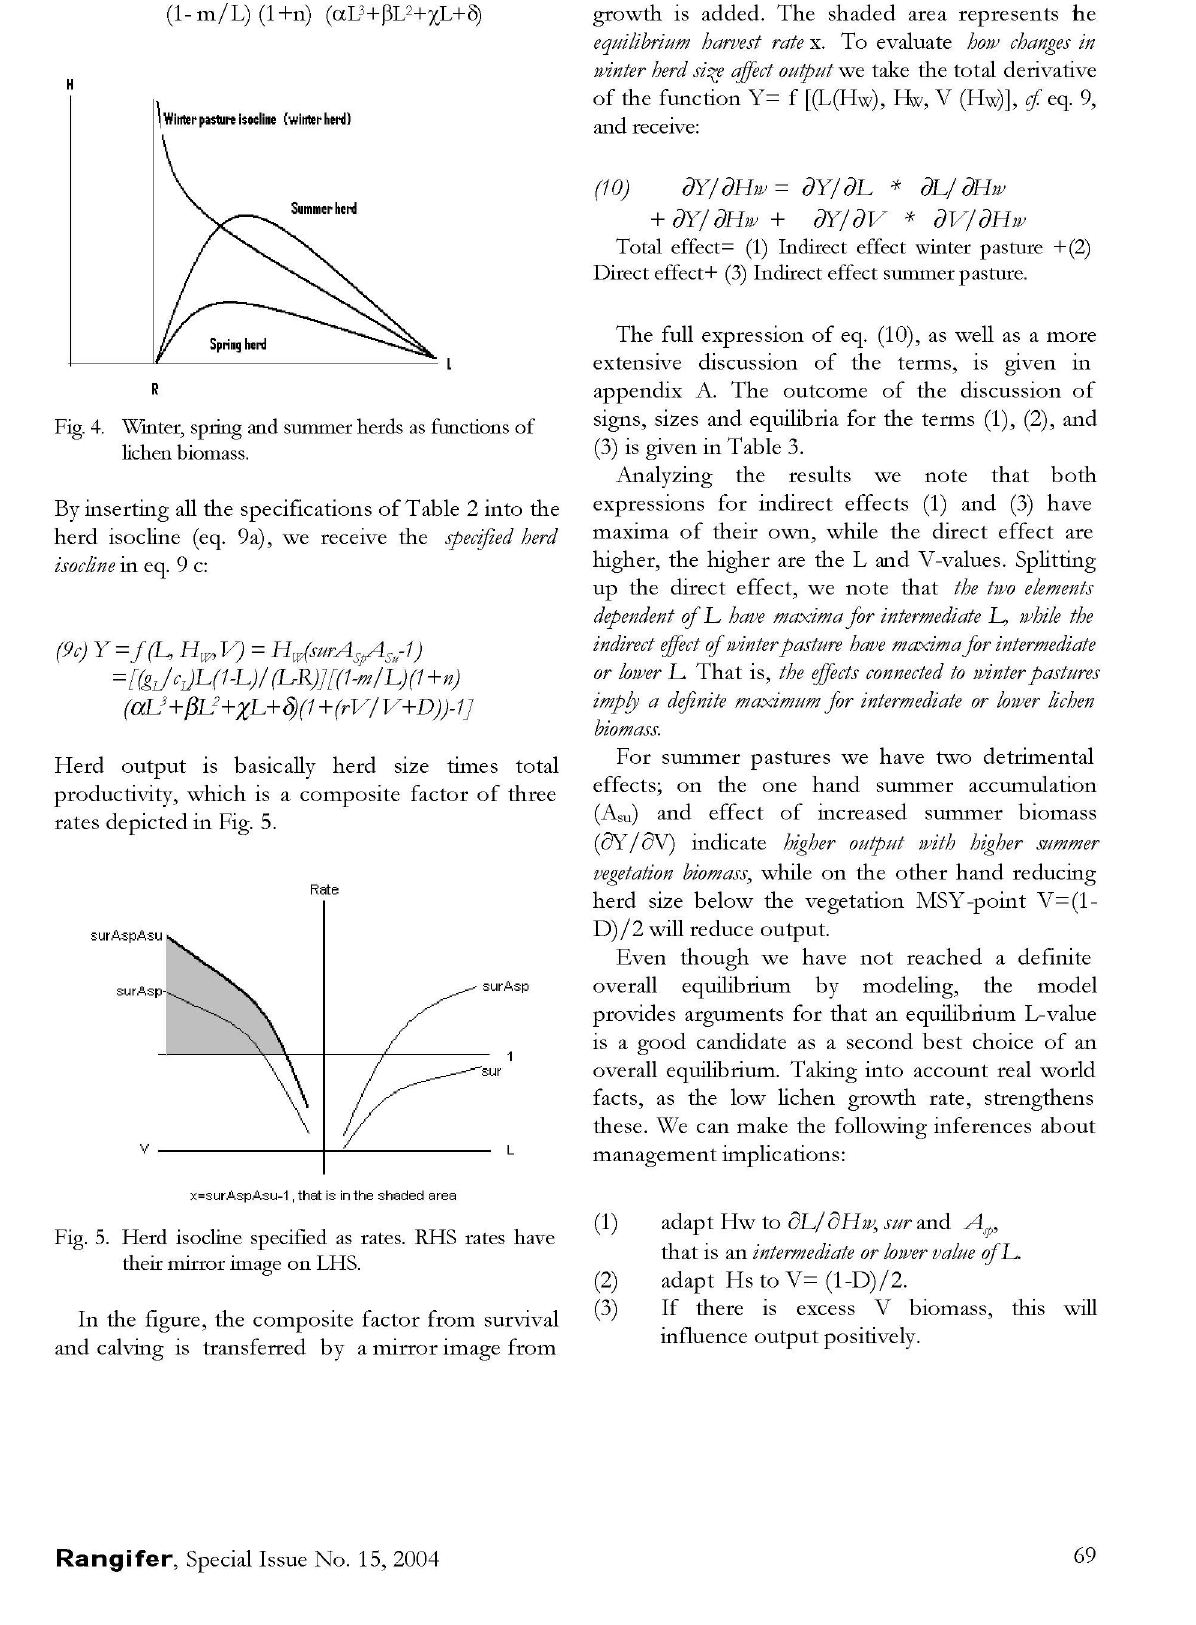
Fig. 4. Winter, spring and summer herds as functions of lichen biomass.